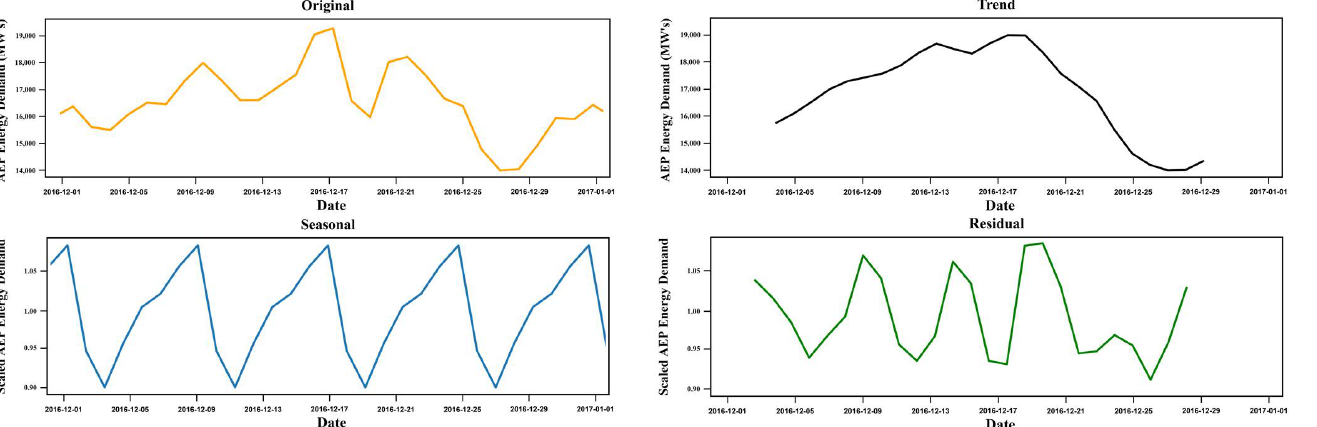
Figure 6. A.E.P. original and decomposed data for Dec 2016.